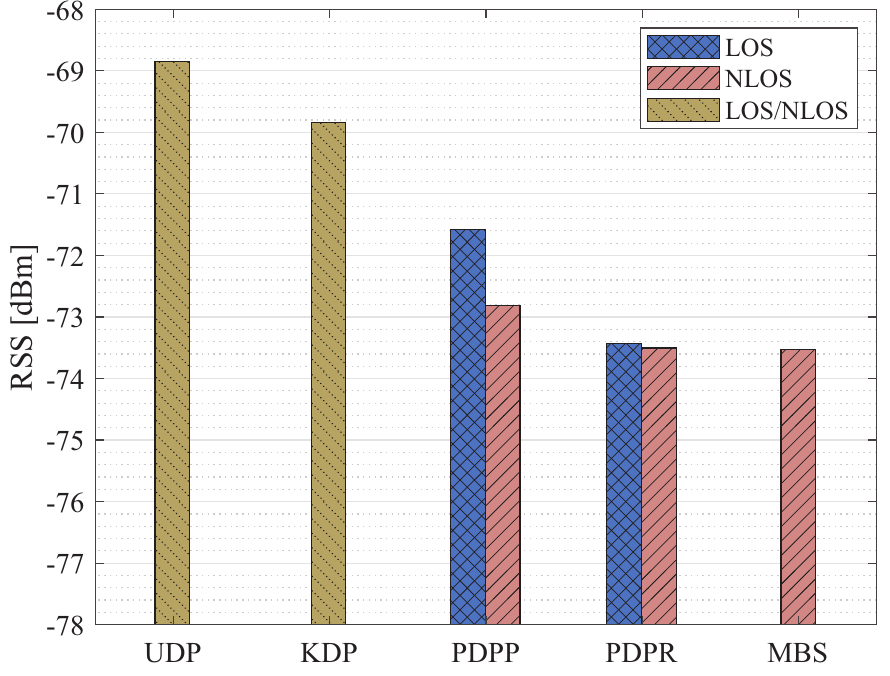
Figure 4. Average downlink RSS with 5 UAV-BSs/PBSs.